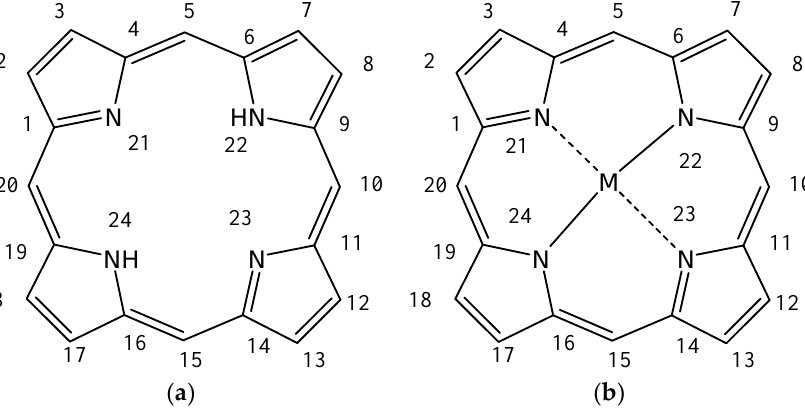
Figure 1. General structures of ( a ) free base porphyrin and ( b ) metalloporphyrin (atoms numbered according to IUPAC (https://doi.org/10.1351/goldbook). (accessed date: 17 January 2023)